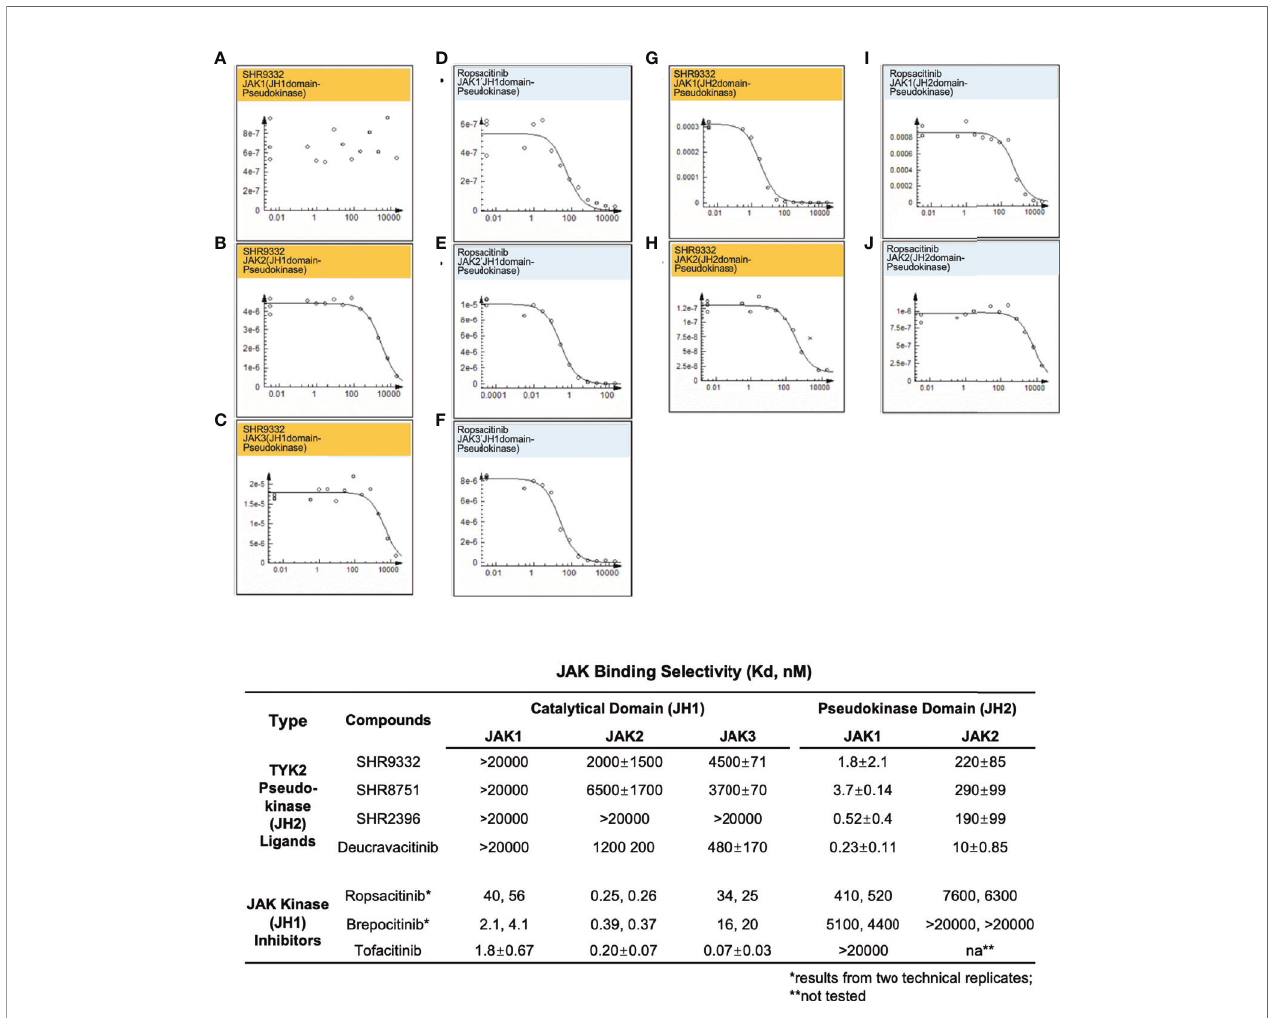
FIGURE 5 | Small molecule TYK2 JH2 pseudokinase ligands demonstrate differentiated binding pattern against JAK family members compared to JH1 kinase inhibitors. (A – C) Representative dose-response curves for binding af fi nity of TYK2 JH2 ligand, SHR9332 to JH1 kinase domain of JAK1 (A) , JAK2 (B) and JAK3 (C) assessed by KdELECT Competition Binding Assay (DiscoverX); (D – F) Representative dose-response curves for binding af fi nity of a TYK2 kinase inhibitor, Ropsacitinib to JH1 kinase domain of JAK1 (D) , JAK2 (E) , and JAK3 (F) assessed by KdELECT Competition Binding Assay (DiscoverX); (G – H) Representative dose-response curves for binding af fi nity of SHR9332 to JH2 pseudokinase domain of JAK1 (G) , and JAK2 (H) assessed by KdELECT Competition Binding Assay (DiscoverX); (I – J) Representative dose- response curves for binding af fi nity of Ropsacitinib to JH2 pseudokinase domain of JAK1 (I) and JAK2 (J) assessed by KdELECT Competition Binding Assay (DiscoverX). Dissociation constants (Kds) for test compound-JH1 or -JH2 domain interactions are calculated by measuring the amount of isolated JH1 or JH2 protein segments captured on the solid support as function of the test compound concentrations. Con fi rmatory studies were performed for the compounds. The fi gures are representative of three independent experiments with duplicates performed for each experiment unless stated otherwise. The average Kd values and standard deviations of each compound from three independent experiments are calculated and summarized in the